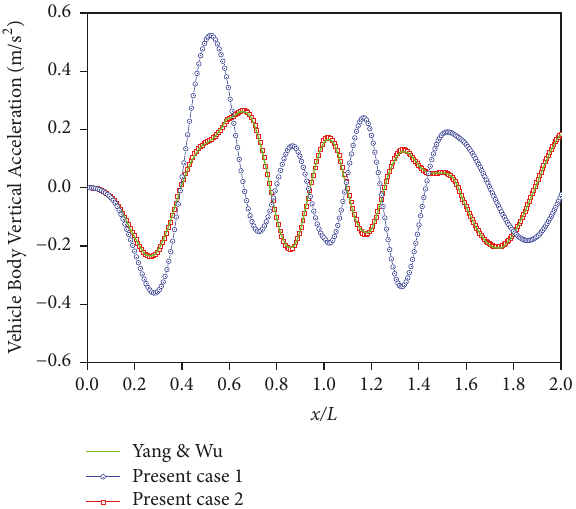
Figure 6: Vertical acceleration of vehicle body.